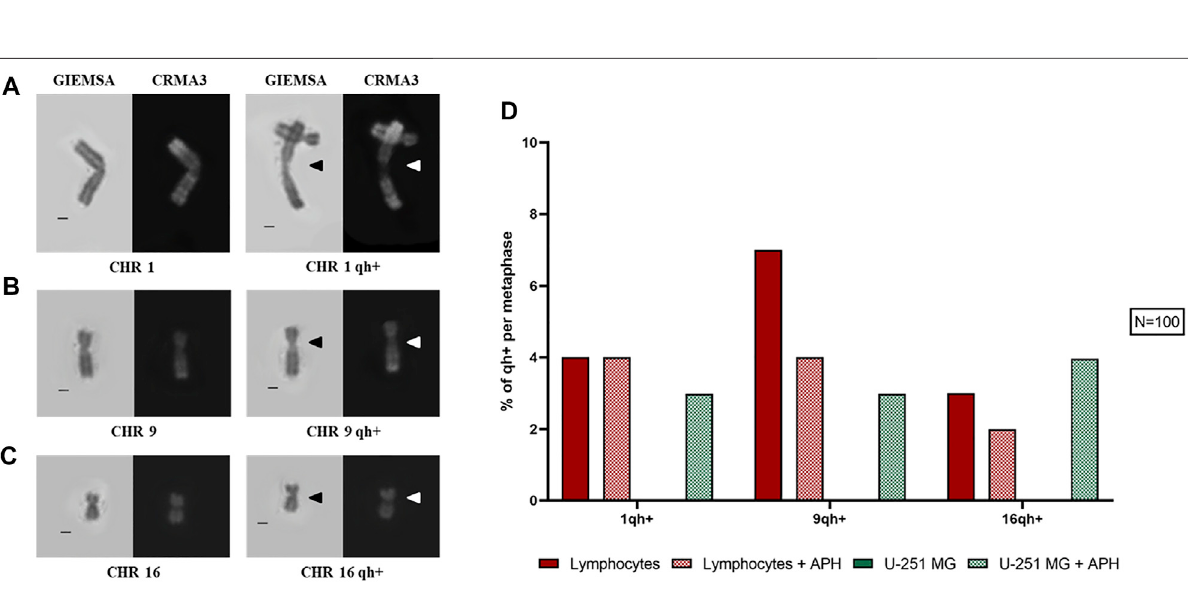
FRA2E (2p13/p12) and FRA2F (2q22) appeared to be